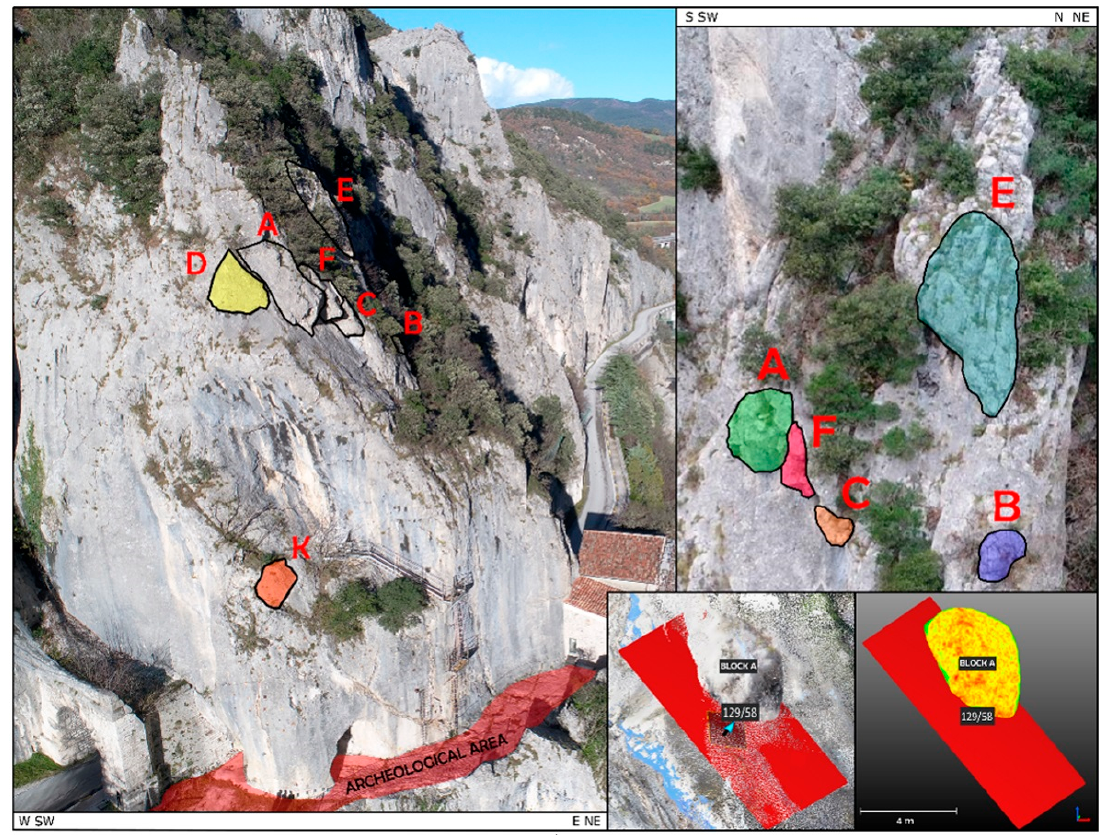
Figure 7. Identification of critical blocks on the slope.